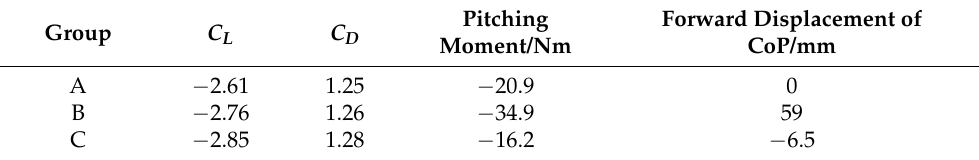
Figure 24. Prototype racing car with shutters, whisker, and rear upper beam wing (group C). Table 8. Simulation results of different